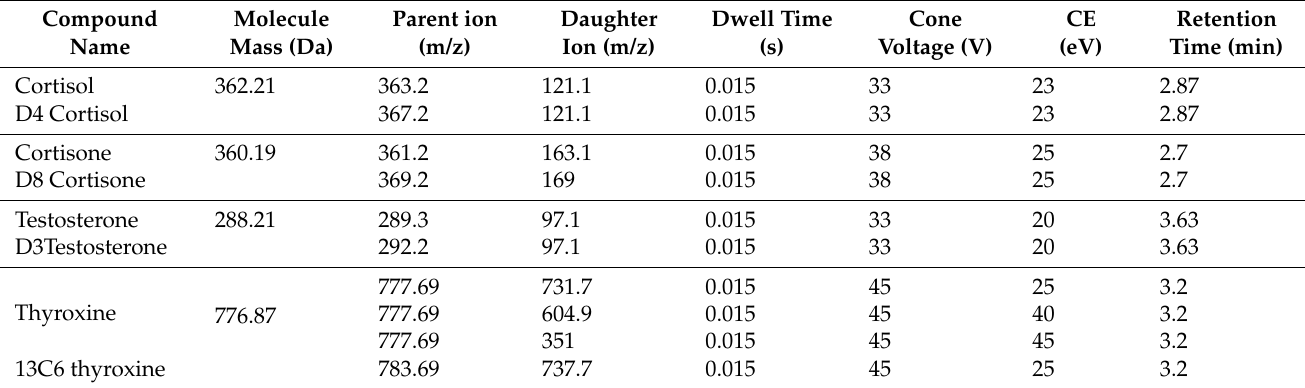
Table 1. Optimized multiple reaction monitoring (MRM) transitions (parent ion to daughter ion), dwell times, cone voltage, collision energy (CE), and retention times for detection and quantification of analytes and isotopic labeled internal